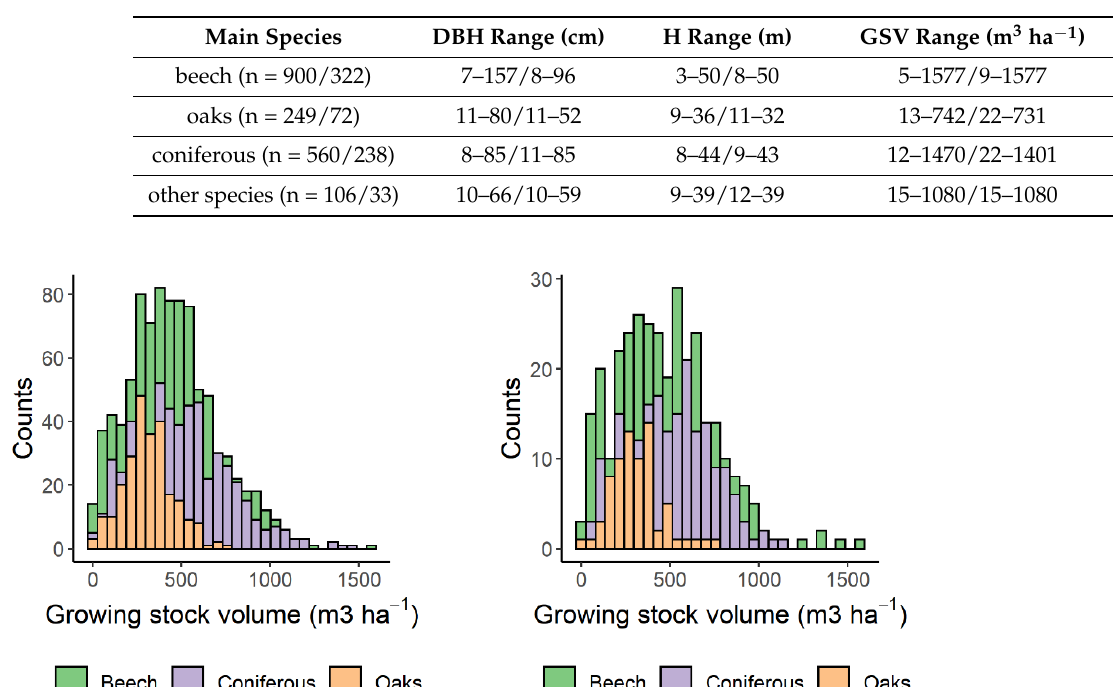
Table 1. Range of plot-wise mean DBH and H and GSV. Values for all/modelling plots (see Section 3.1).